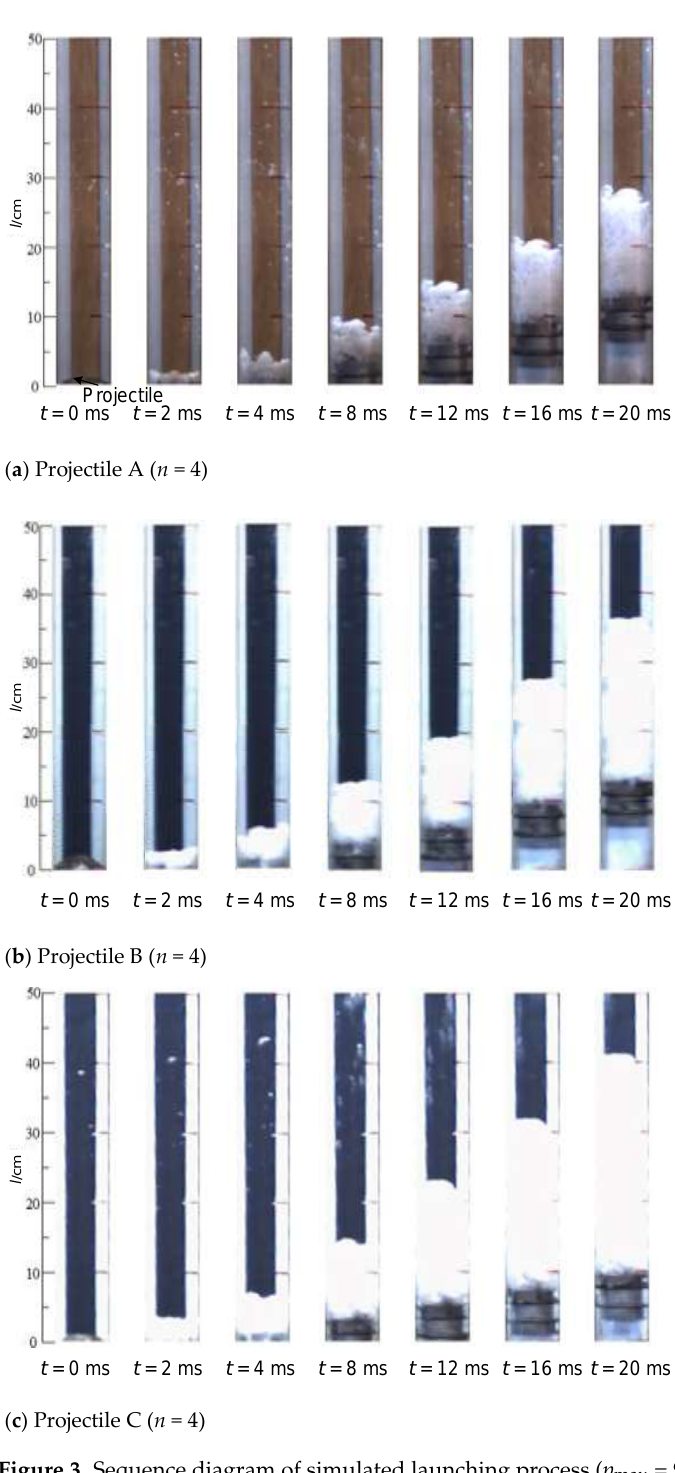
Figure 3. Sequence diagr am of simulated launching process ( p max = 9.9 MPa). In order to further understand the multiphase hydrodynamic characteristics of the simulated launching process, the variation curves of the gas-curtain displacement and the projectile velocity with time are given in Figures 4 and 5, respectively. Among them, the gas-curtain displacement represents the drainage capacity of the gas curtain, and the pro- jectile velocity reflects the energy distribution effect. It can be seen from Figure 4 that the